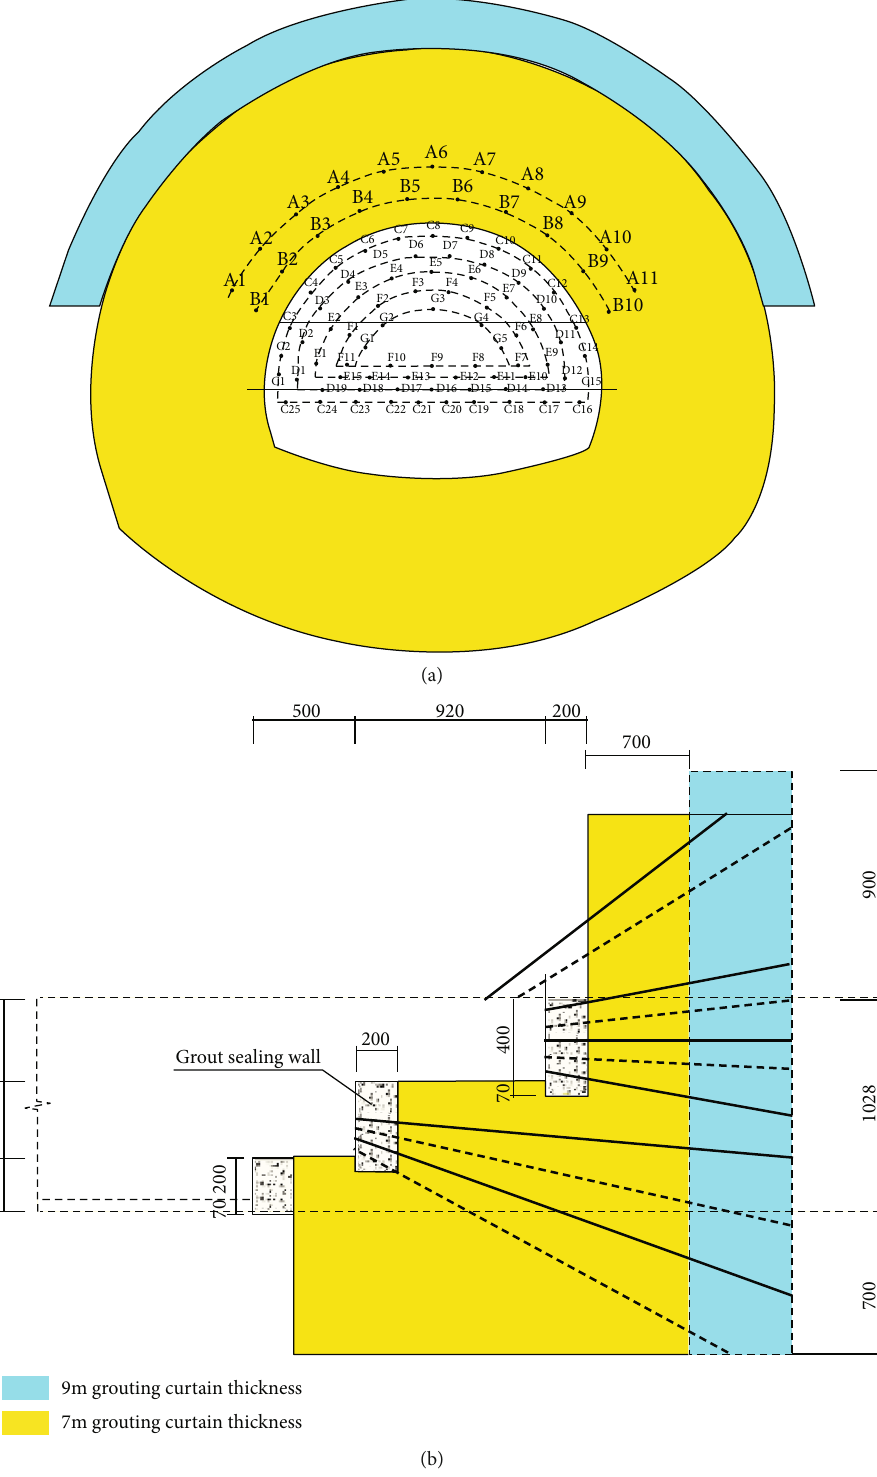
Figure 4: Schematic diagram of grouting curtain thickness: (a) cross section and (b) longitudinal pro fi